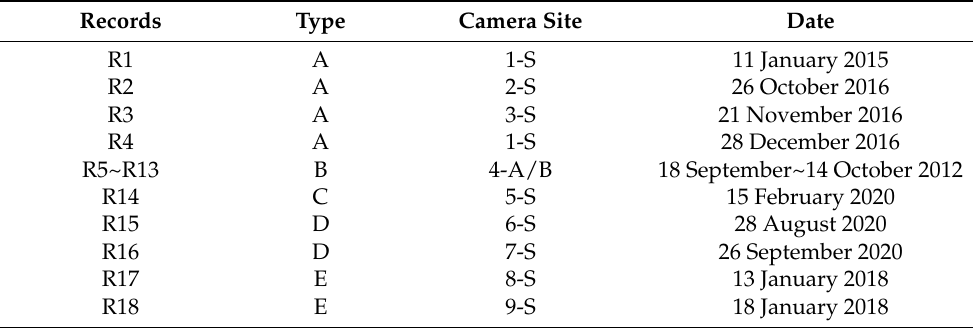
Table 1. Information about the 18 video records. Camera sites 1~9 contained nine different observa- tion sites; ‘4-A/B’ refers to two cameras in a pair; ‘S’ refers to a single camera at the site. From 18 September~14 October 2012, nine videos of five independent events were captured. Type A, white patches on the head and white forelimbs; Type B, white head and lower forelimbs; Type C, gray on the muzzle and part of the forehead, and only the hind foot was black; Type D, lack of black fur; and Type E, pale yellow on the whole body, the color of the face and paws was even lighter, and the nose was pink (de-pigmented).